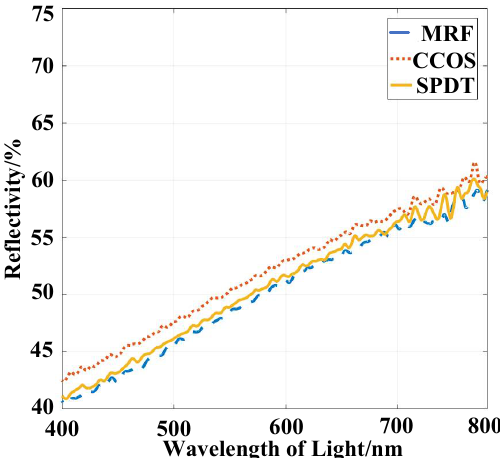
Figure 13. Visible light band reflectance comparison of sample 1.